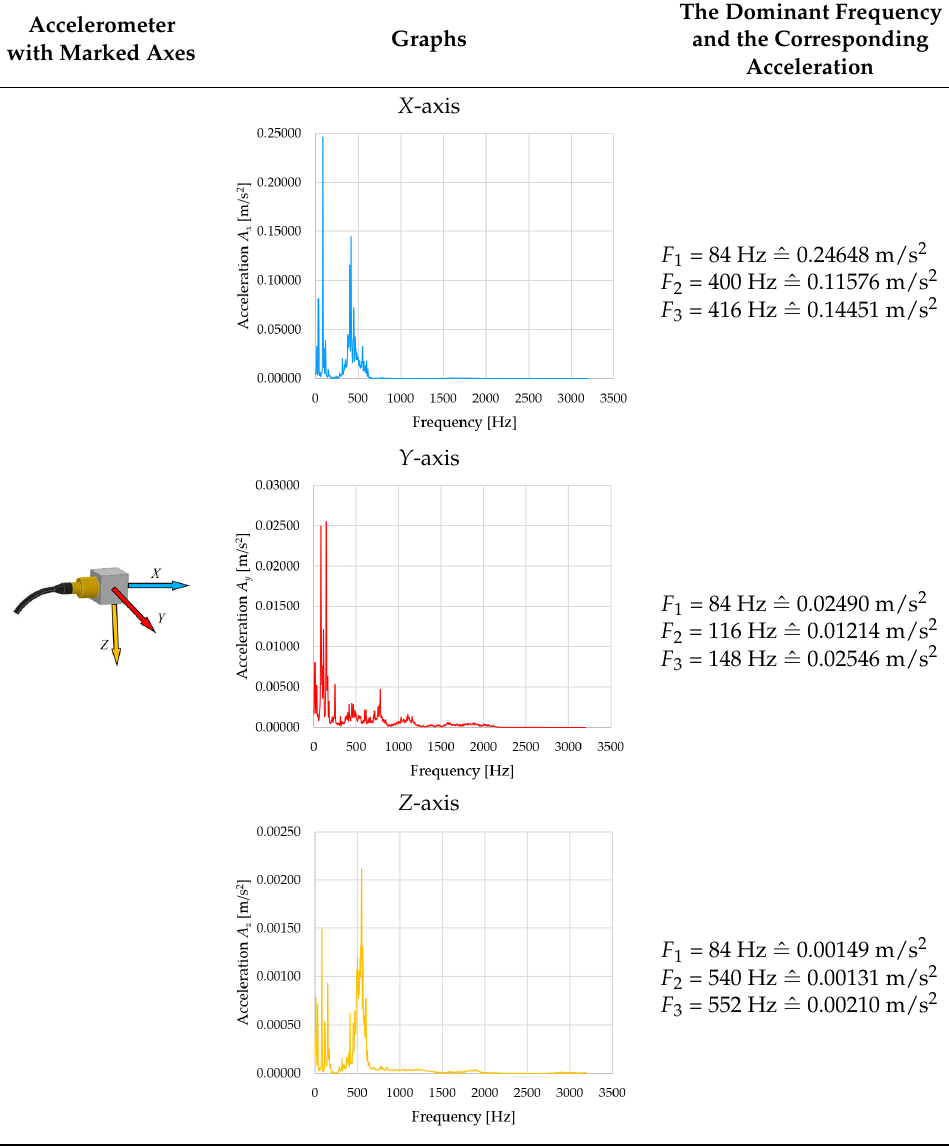
Table 4. The course of acceleration depending on the frequency for velocity 60 % (78.6°/s).